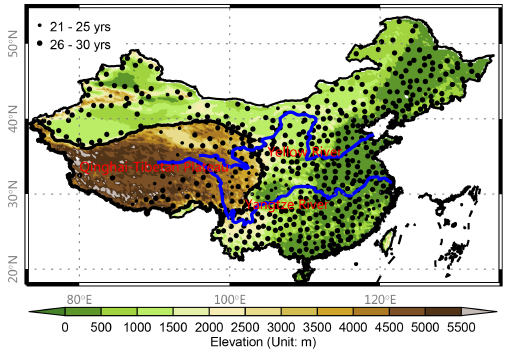
Figure 1. Map of meteorological stations across China used in this study. Background reflects elevation and sizes of circles reflect data availability during the period from July 1971 to June 2001. Bound- ary line of Qinghai-Tibetan Plateau is from Zhang et al.